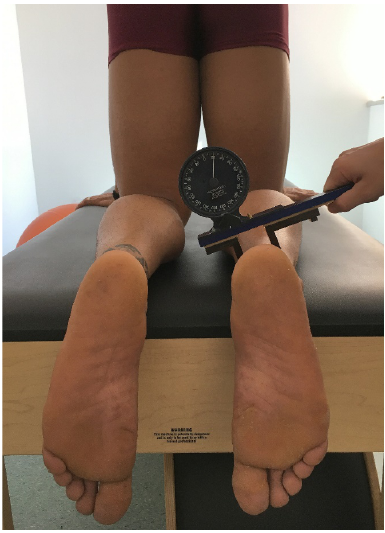
Figure 3. Subject in quadruped stance and tips of the fork of Pluritor T touching malleoli from dorsal to measure tibial torsion (figure with kind permission of Thieme group, ©Thieme).